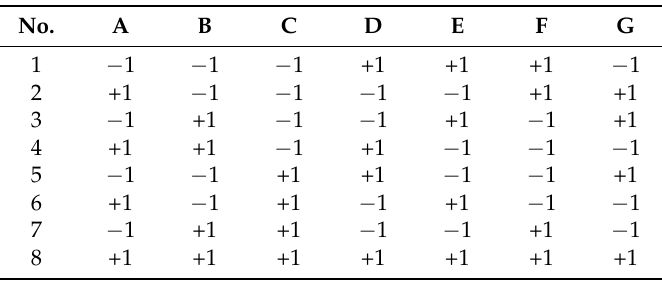
Table 4. (2 7 − 4 ) Array for DOE. III